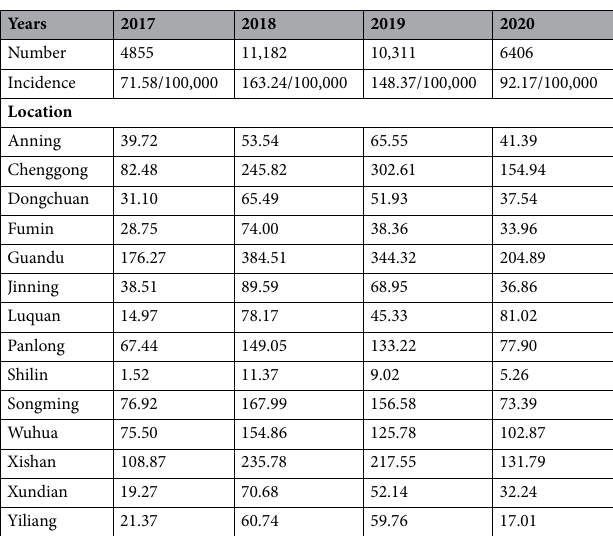
Table 1. The spatial distribution of HFMD annual incidence of districts and counties in Kunming,